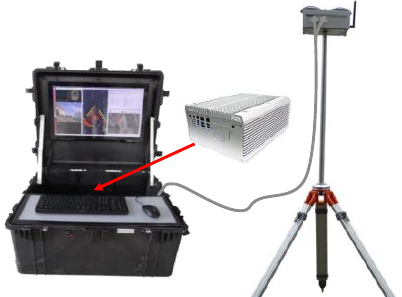
Figure 5: Central Ground and Control Station (GCS)